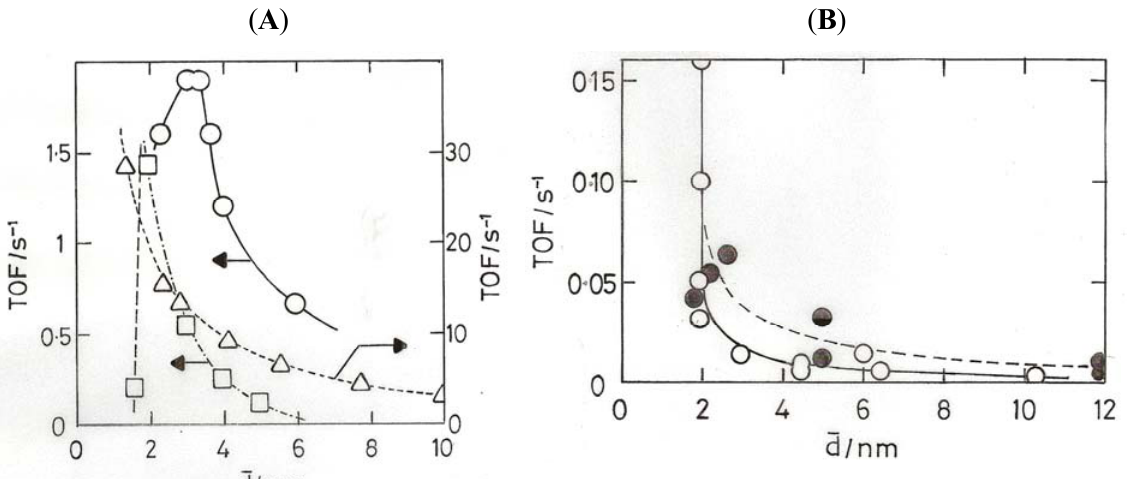
Figure 3. ( A ) ‘Model’ Au/TiO (110) at 353 K [23]. ( B ) ‘Model’ Au/TiO 2 (110) at 300 K [38]. ( D ) Au/TiO ( C ) ‘Model’ Au/TiO 2 Au/Co O (filled points) prepared by DP 3 4